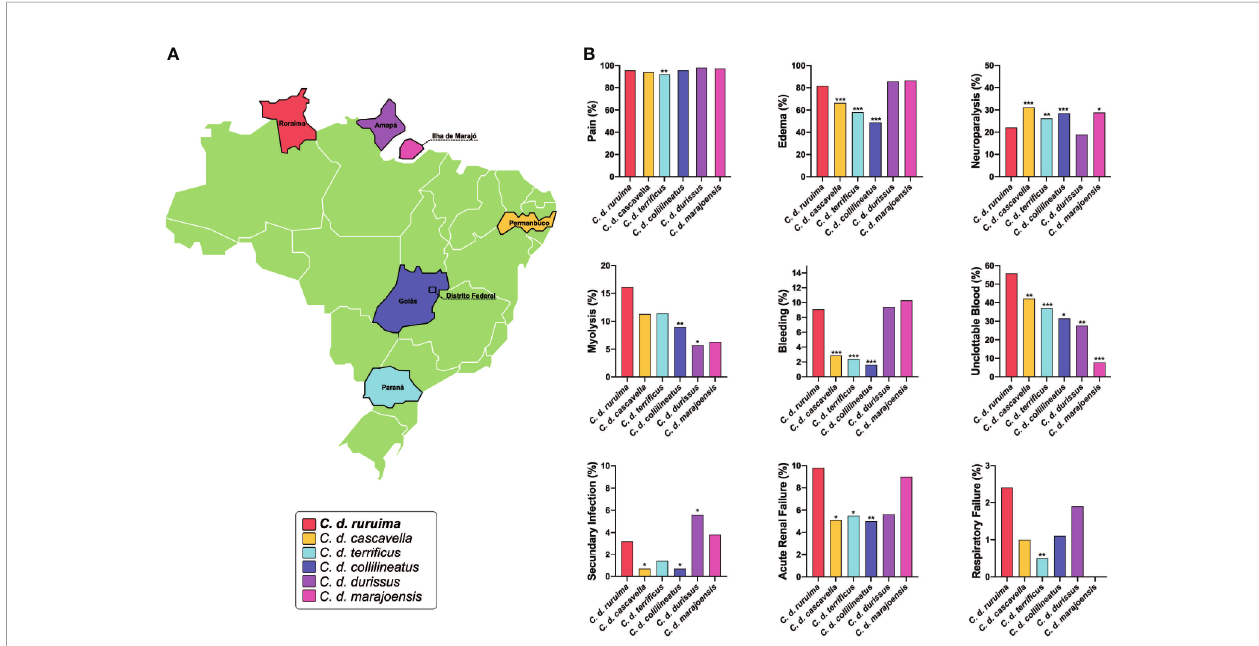
FIGURE 4 | Cross-country comparison of local and systemic manifestations in envenomings caused by different Crotalus durissus subspecies. Data was gathered from the SINAN, from 2010 to 2019. Information was strati fi ed by state, considering the geographic distribution of six C. durissus subspecies. (A) Only states without subspecies overlap in geographic distribution were selected. For statistical comparison, X-square or Fisher ’ s tests were performed in STATA software (StataCorp. 2013: Release 13. College Station, TX, USA), using the group of patients envenomed by C. d. ruruima as the reference. After the univariable analysis, any difference in the frequency of clinical manifestations between C. d. ruruima and another subspecies envenoming at a signi fi cance level of p <0.20 were included in a multivariable analysis, adjusting by age, sex, and time to medical assistance. Statistical signi fi cance was considered if p <0.05 in the Hosmer-Lemeshow goodness- of- fi t test. (B) Only clinical manifestations with any signi fi cant difference are presented. Number of patients according C. durissus subspecies: C. d. ruruima (n=396), C. d. cascavella (n=990), C. d. terri fi cus (n=1,016), C. d. collilineatus (n=2,093), C. d. durissus (n=54), C. d. marajoensis (n=80); * p < 0.1; ** p < 0.05; *** p <